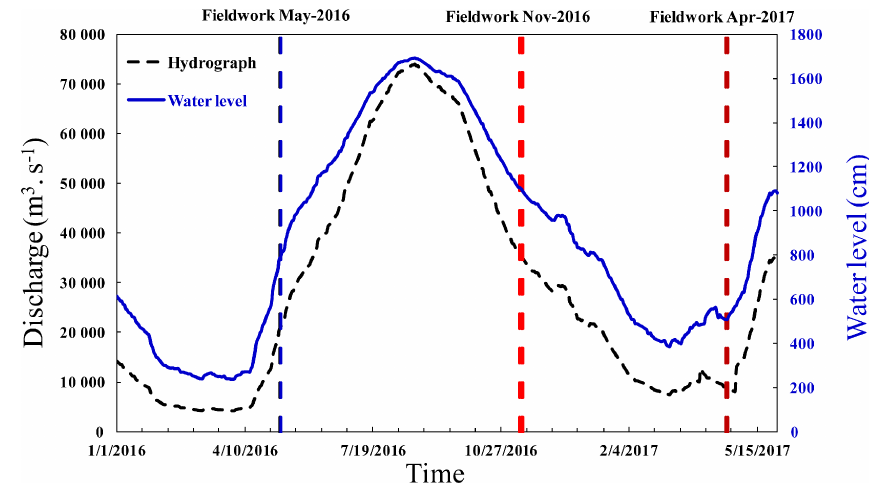
Figure 2. Daily recorded discharge and gauge data from Ciudad Bolivar station during the study period (2016–2017).